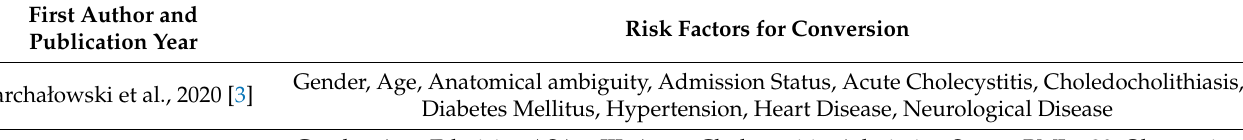
Table 2. Risk factors examined by studies included in the meta-analyses